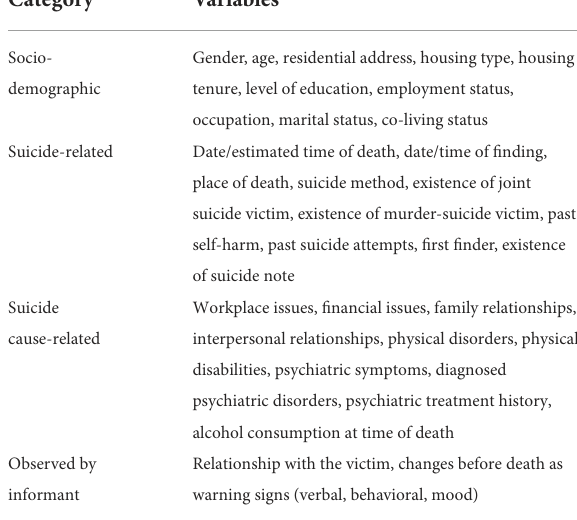
TABLE 1 List of individual-level variables appearing in South Korean national suicide